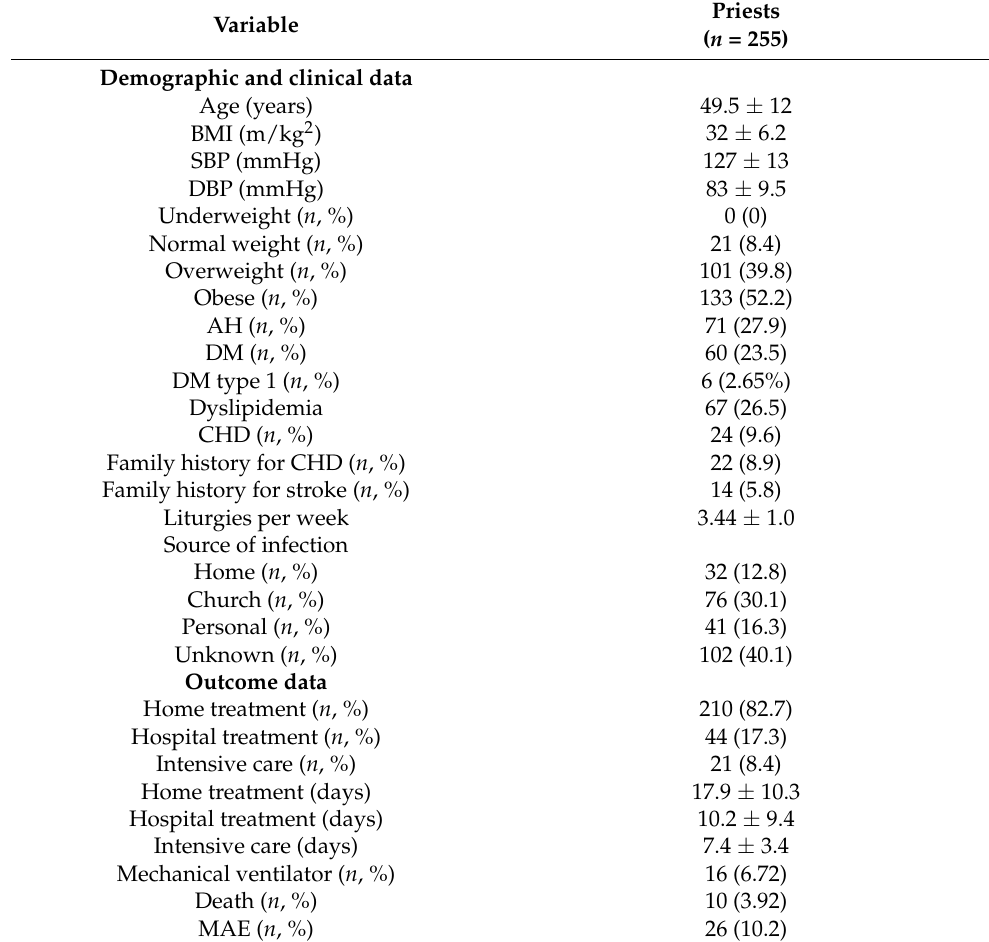
Table 1. Demographic, clinical, and outcome data of Coptic